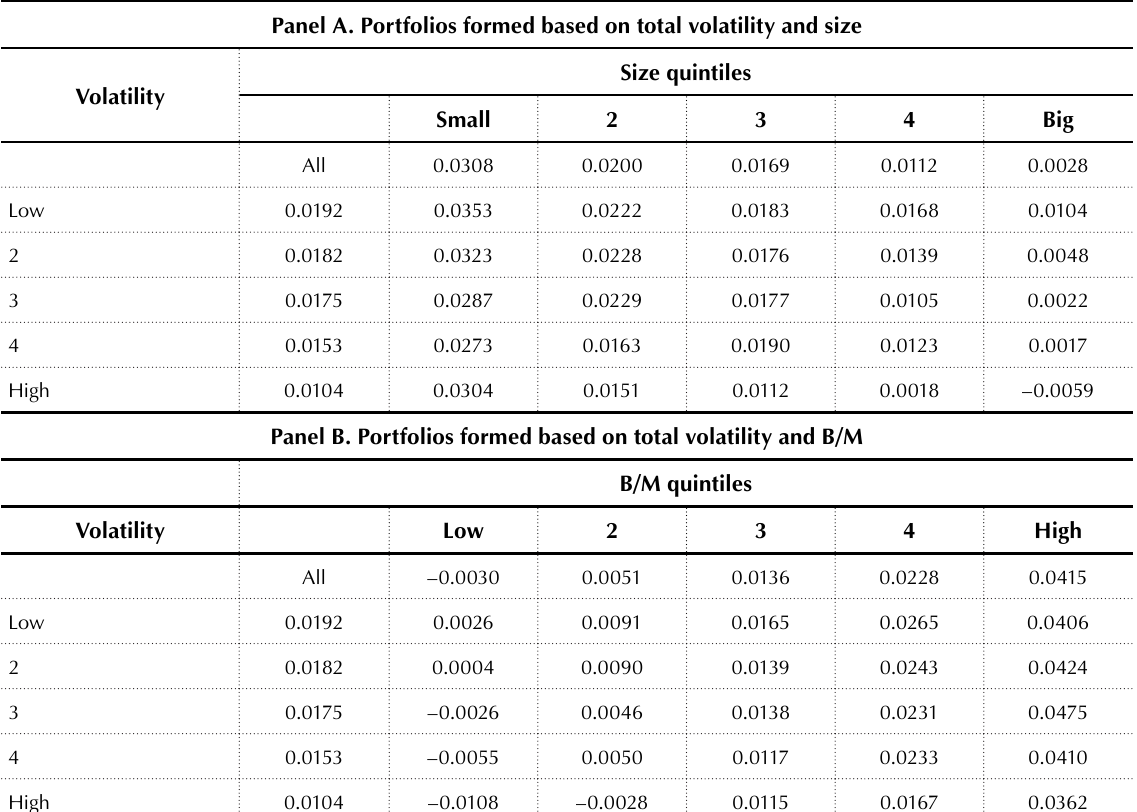
Table 6. Average returns for double-sorted portfolios formed on total volatility, size, and book-to- market ratio